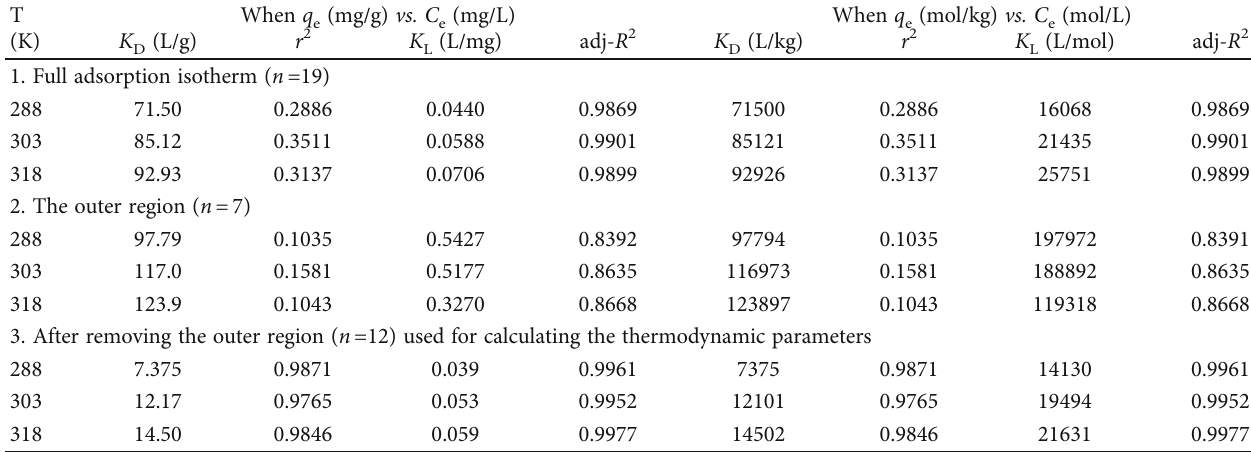
and K based on D L